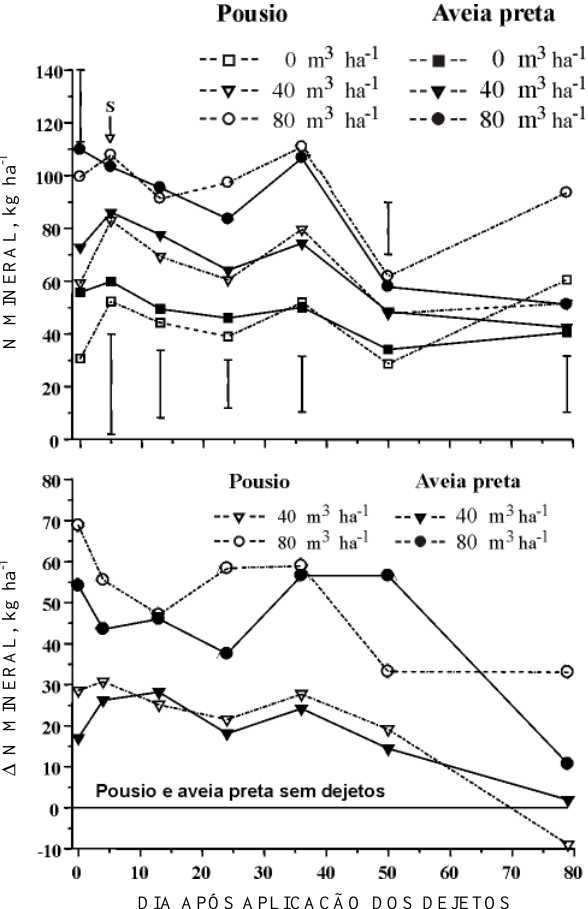
Figura 2. Quantidades de N mineral na camada de 0- 60 cm do solo (soma das camadas 0-5, 5-15, 15-30 e 30-60 cm) durante o desenvolvimento da aveia e da vegetação espontânea (pousio), nas doses de 0, 40 e 80 m 3 ha -1 de dejetos durante o outono/ inverno (a) e diferença ( ΔΔΔΔΔ N mineral) entre as quantidades de N mineral na camada de 0–60 cm do solo nos tratamentos com aplicação de dejetos líquidos (40 e 80 m 3 ha -1 ) na aveia e na vegetação espontânea (pousio) e os tratamentos sem aplicação de dejetos (0 m 3 ha -1 ) (b). Barras verticais indicam diferença mínima significativa (Tukey a 5 %). A flecha indica o momento da semeadura (S) da